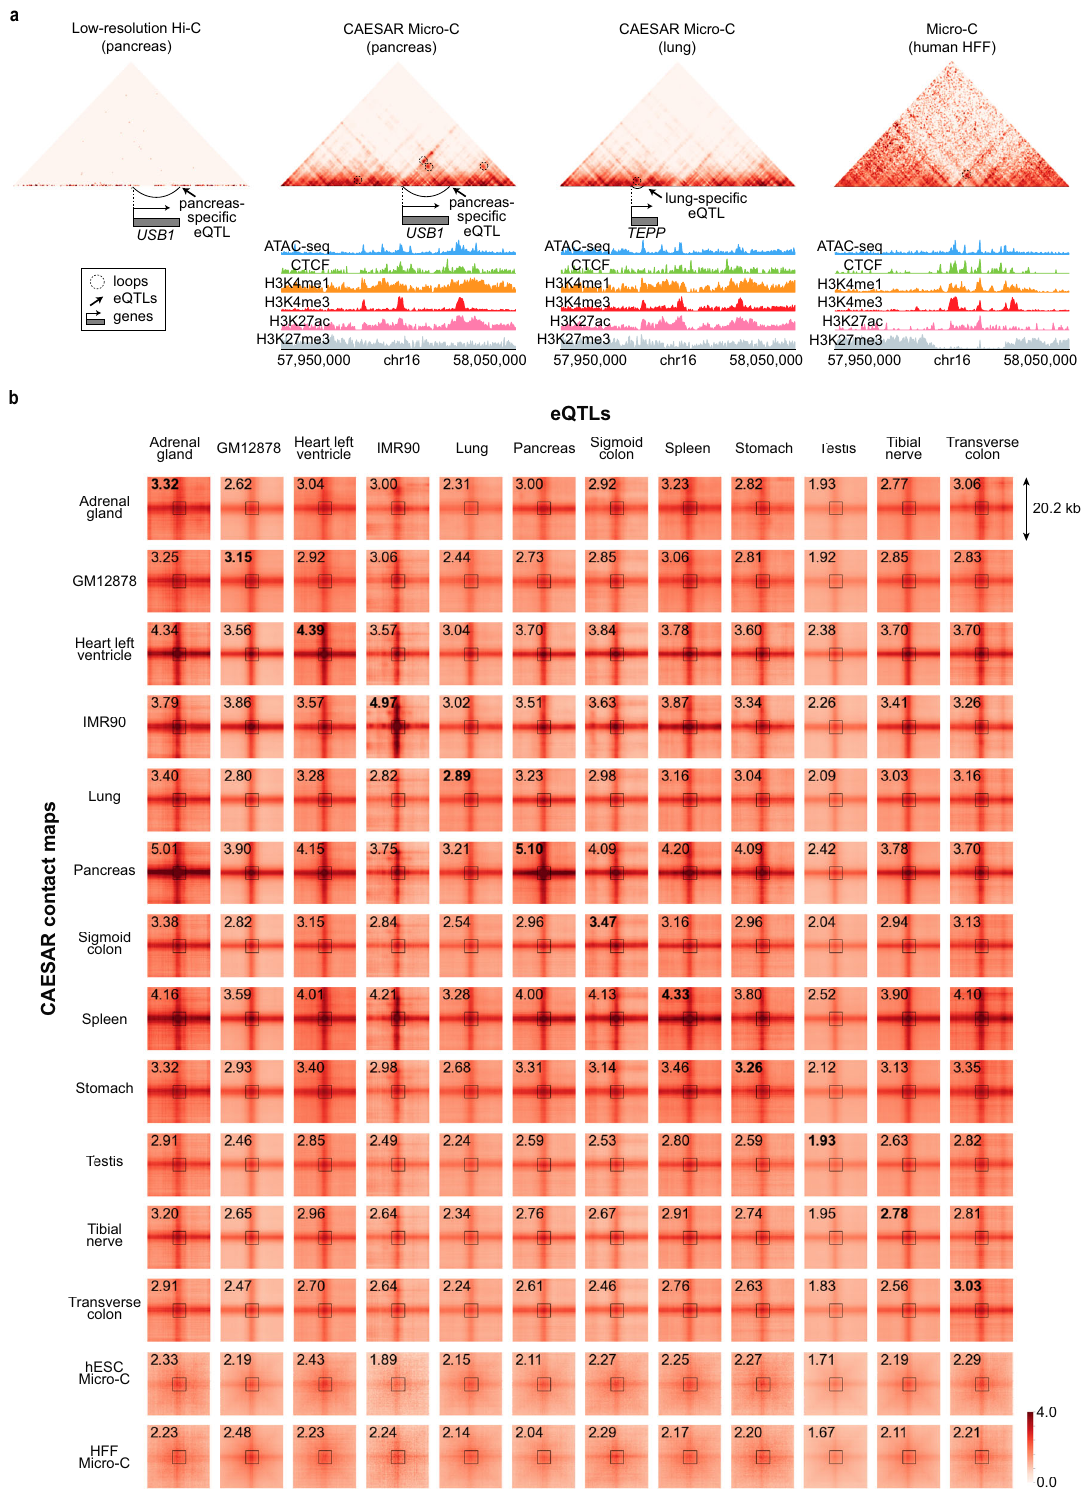
Fig. 5 The enrichment of eQTL-gene interactions in CAESAR-imputed contact maps. a The loop between gene USB1 ’ s TSS and its pancreas-speci fi c eQTL, which cannot be observed on the original Hi-C contact map, appears on the CAESAR-imputed contact map for the pancreas. Although gene TEPP ’ s eQTL is lung-speci fi c, the corresponding loop can be called from the CAESAR-imputed contact maps for both lung and pancreas. b Pile-up analysis of the chromatin contacts between eQTLs and their corresponding gene TSS from twelve different human tissues and cell lines on CAESAR-imputed contact maps and Micro-C contact maps. The average contact values in the central 5 × 5 squares are marked on the plots, in which the bold fonts indicate that eQTLs and CAESAR-imputed contact maps are from the same tissue/cell